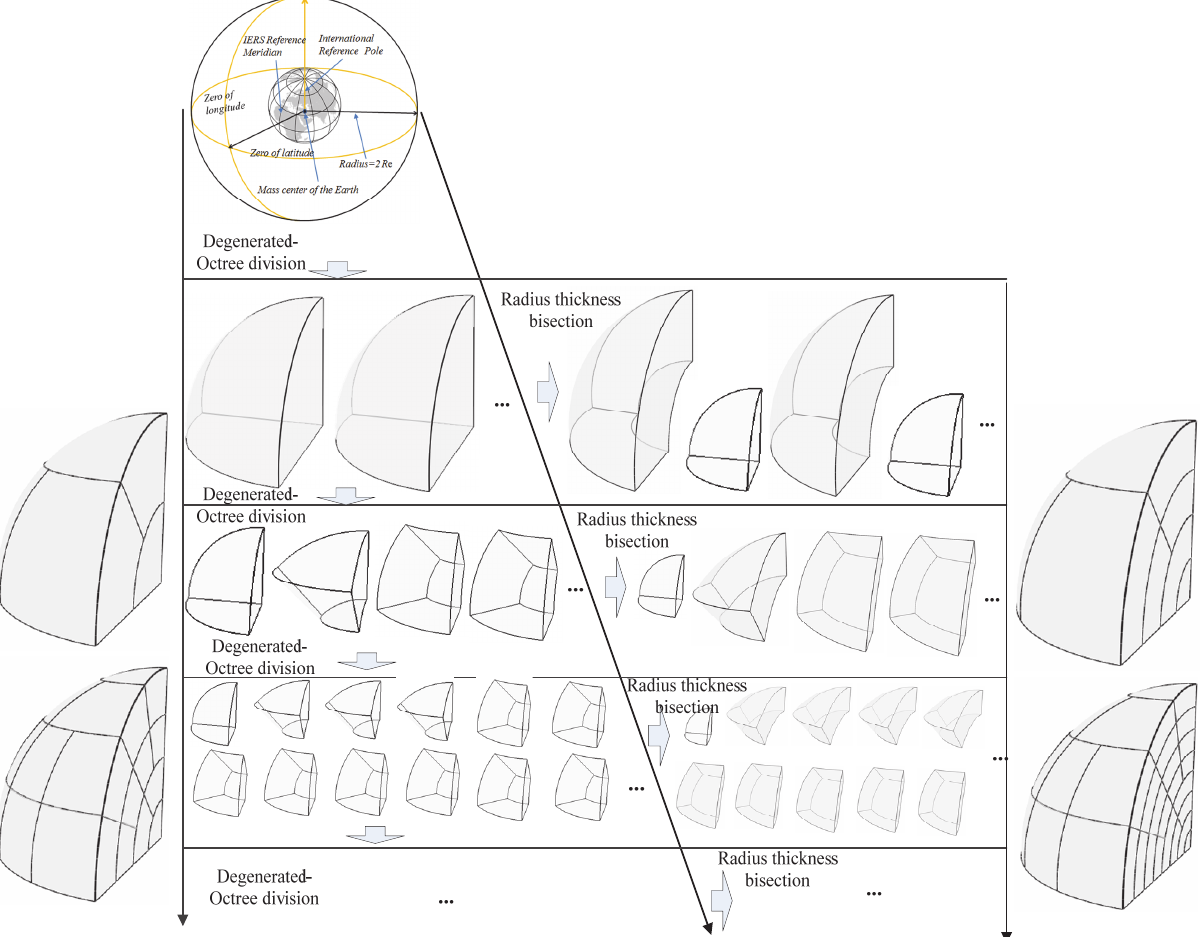
Figure 4 Hierarchical tree of SDOG-R. The SDOG-R is achieved by a recursive radial thickness bisection on an